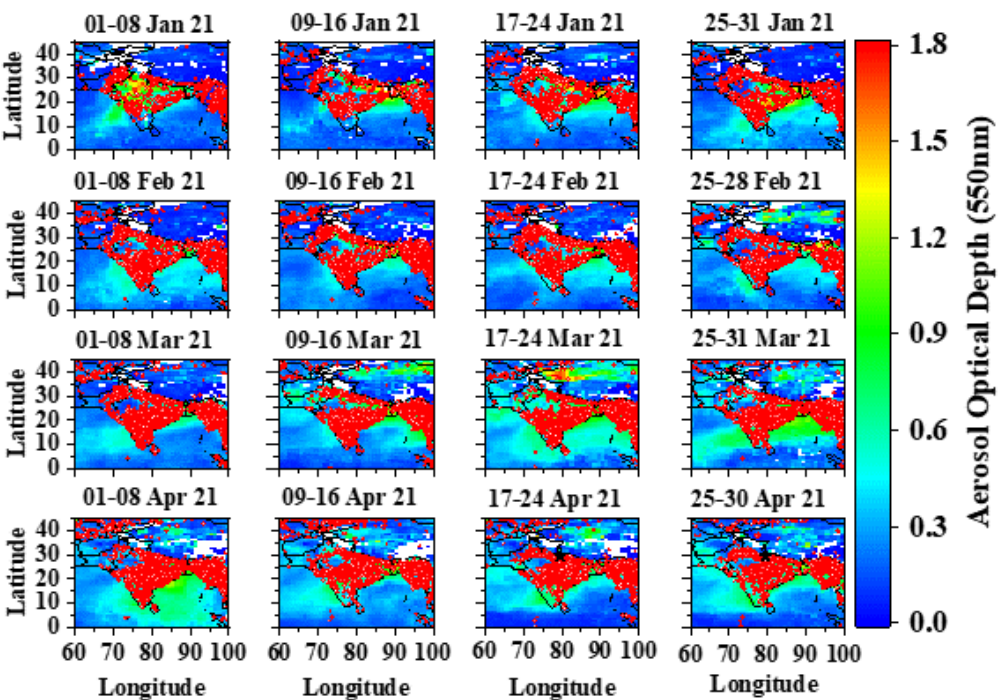
Figure 6. Weekly average maps of AOD at 550 nm over the Indian subcontinent using the dark target and deep blue combined products of MODIS Aqua and Terra Satellites for the period of January to April 2021. The red dots over the maps show the MODIS fire counts during the same period under consideration.